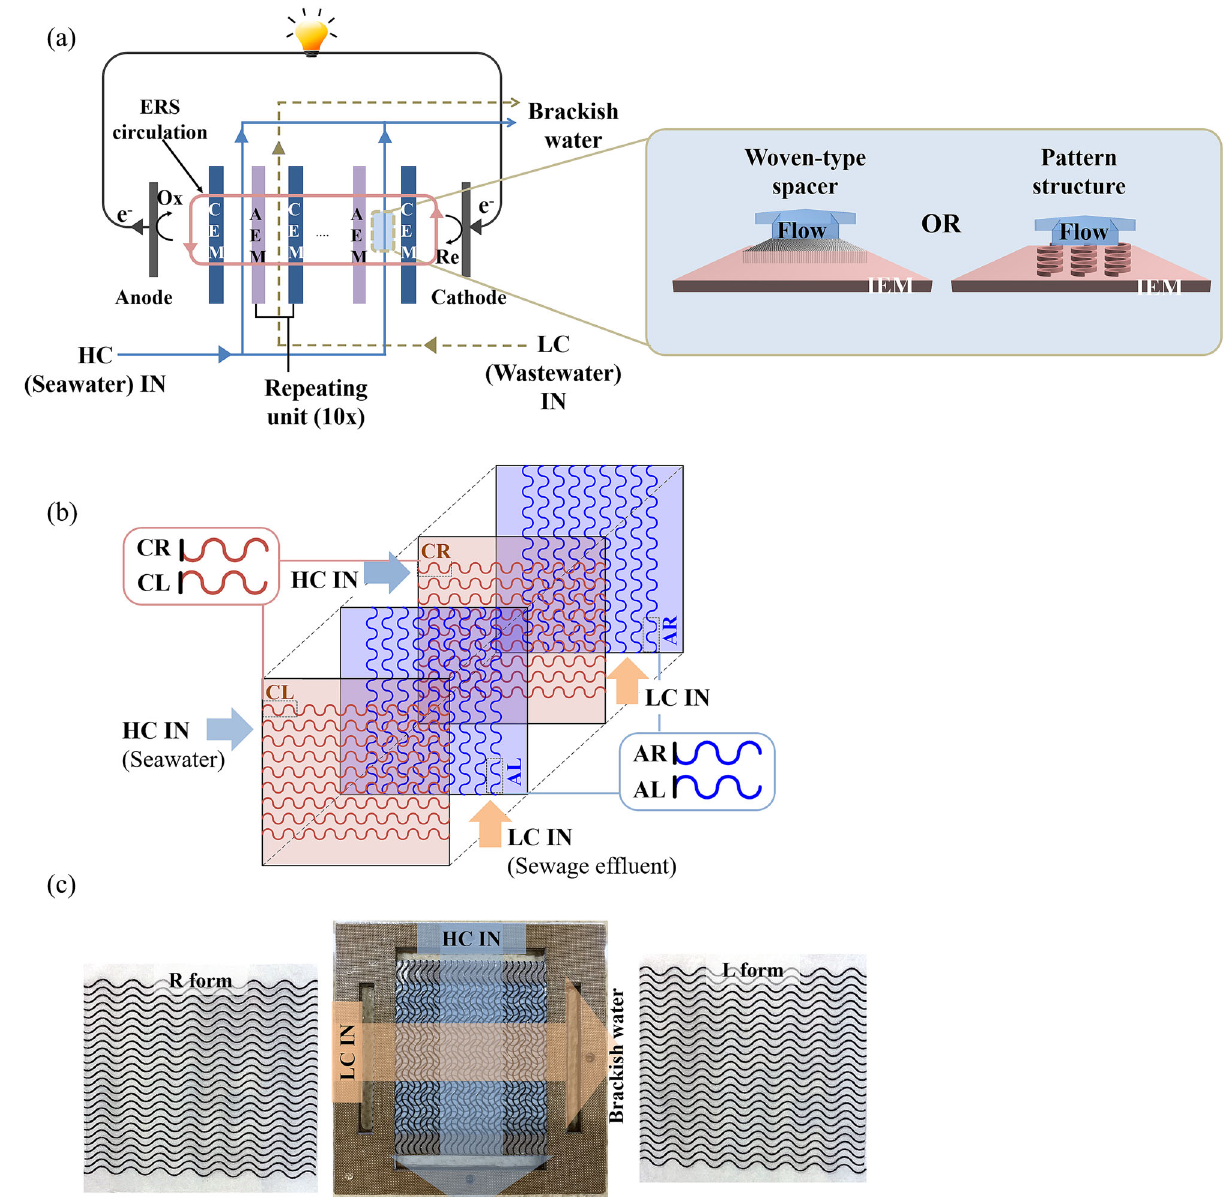
Fig. 1 Schematic of the RED process when using a woven-type spacer or patterned membrane, the method for stacking the patterned membranes with their mirror images, and photographic image of the cross- fl ow stacked patterned membranes. a, b Show schematic of the RED process and the method for stacking the patterned membranes with their mirror images, respectively. c Shows photographic image of the cross- fl ow stacked patterned membranes (L and R form) used in this study. HC and LC indicate high and low concentrations of the electrolyte,